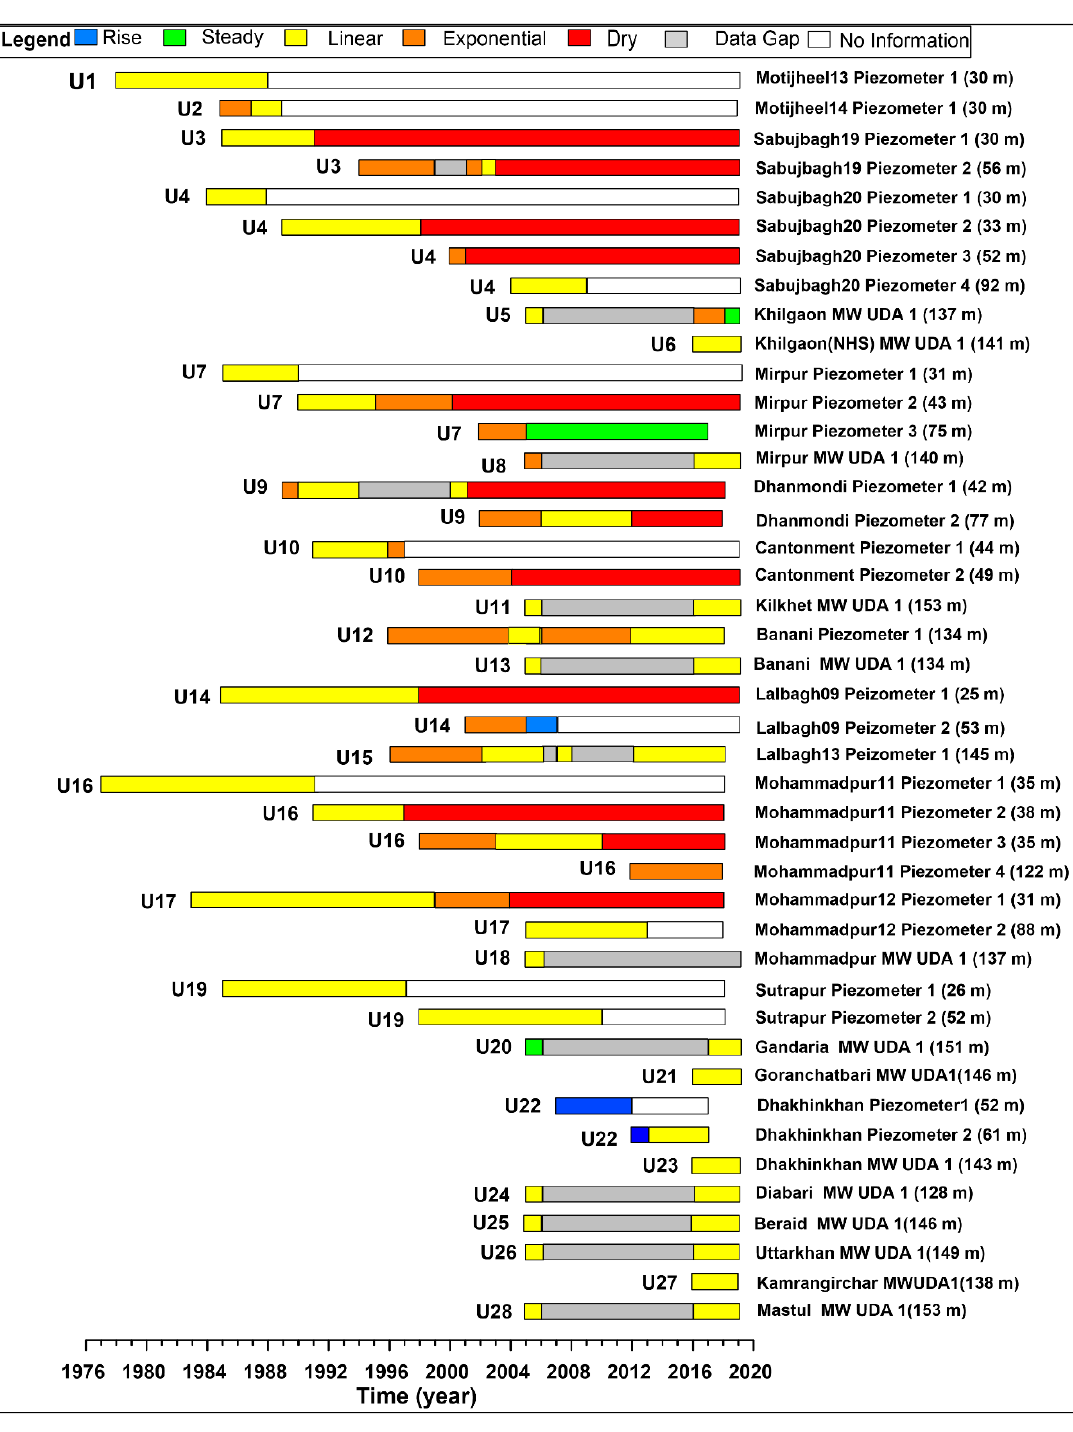
Figure 13. Synthetic graphical overview of piezometric trends of UDA in Dhaka city. Rise (increasing PL), Steady (no PL trend), Linear (declining PL) and Exponential (increasing PL slope) are used to characterize the hydrograph.